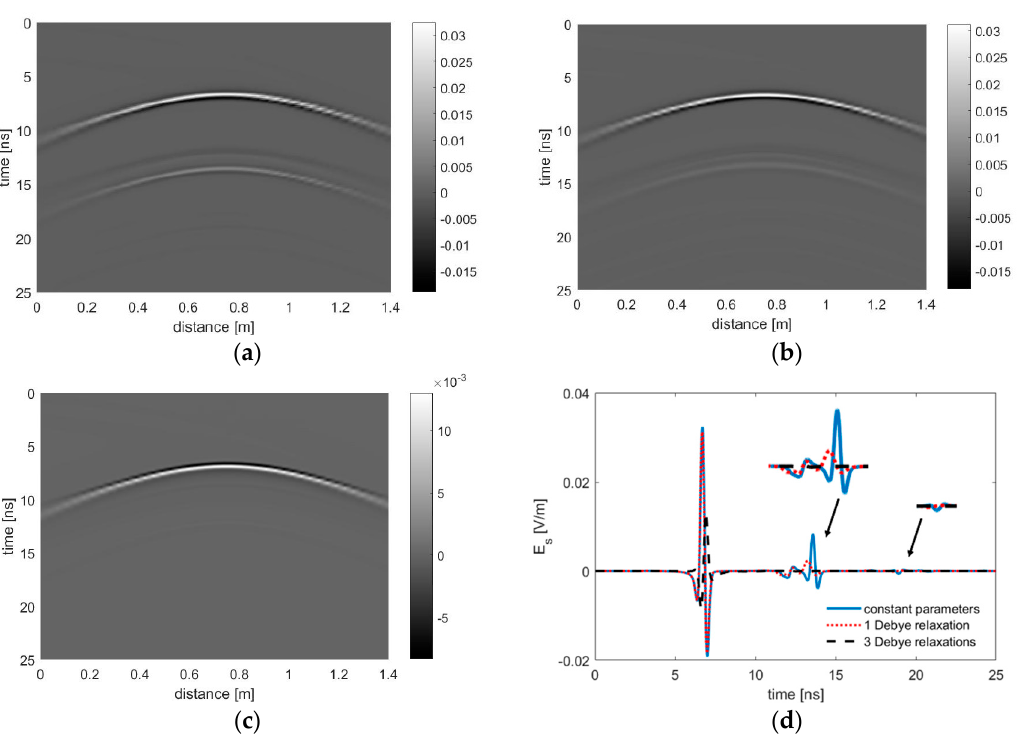
Figure 7. B-scan radargrams for a clay target with different electrical and dielectric parameters in Equation (35): ( a ) constant parameters; ( b ) one Debye relaxation; ( c ) three Debye relaxations; ( d ) comparison of the A-scan above the target (receiver #21) for the permittivity models of cases ( a – c ).